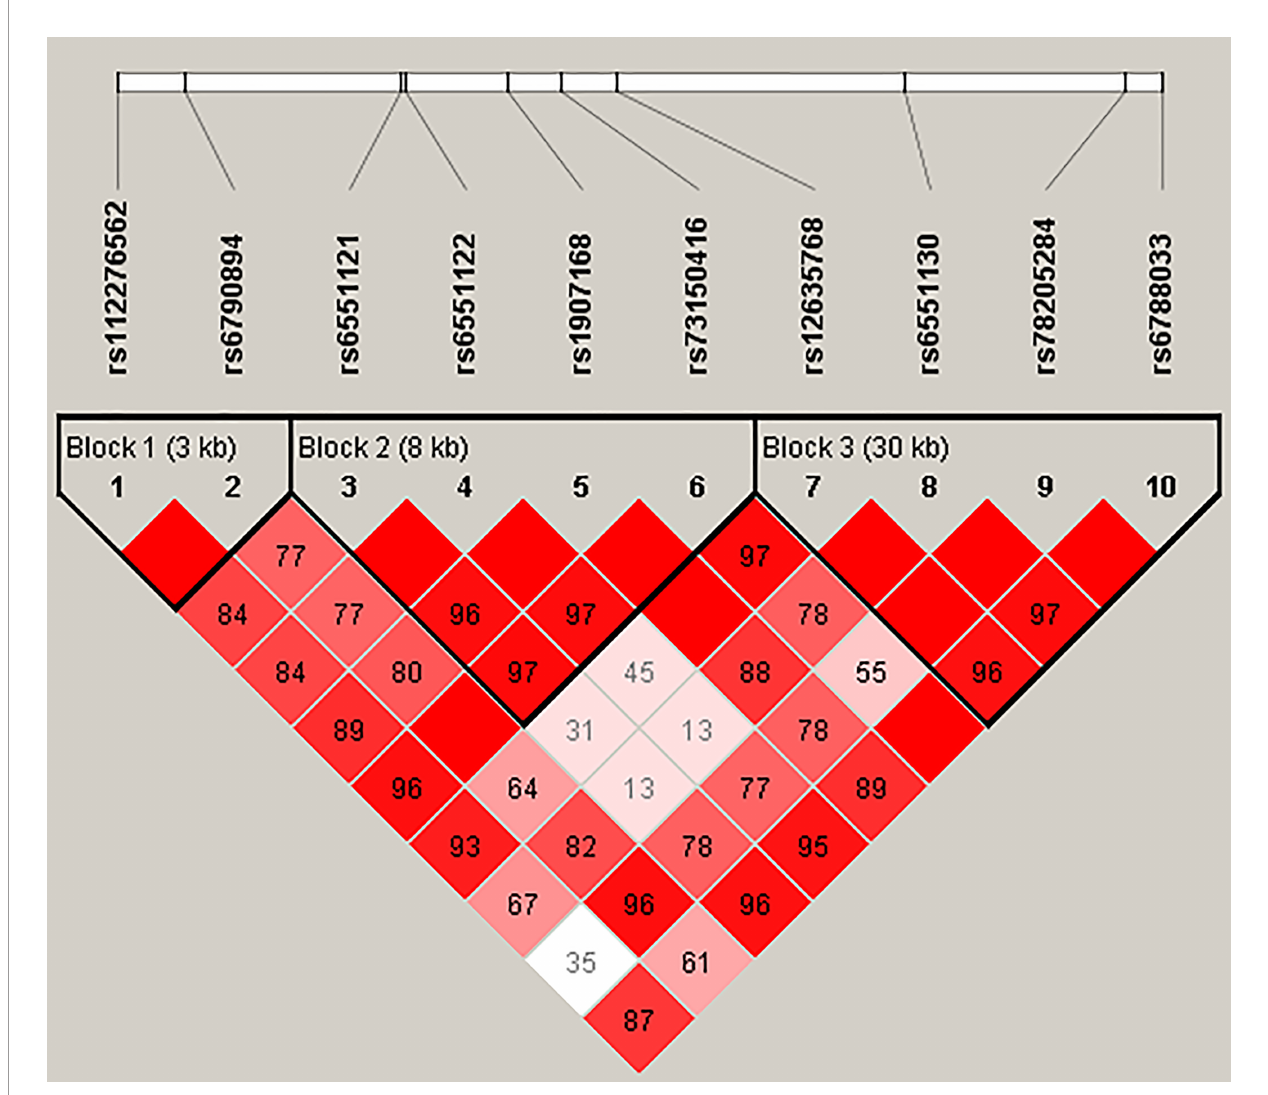
FIGURE 1 | Haplotype block map for ten SNPs in the LRRC3B gene. The numbers inside the diamonds indicate the D ′ for pairwise analyses.